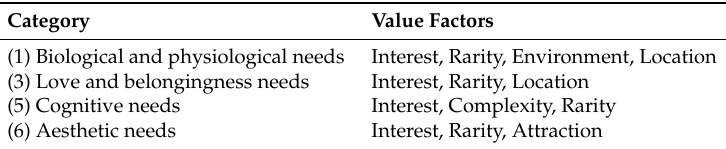
Table 4. Category and value factors.